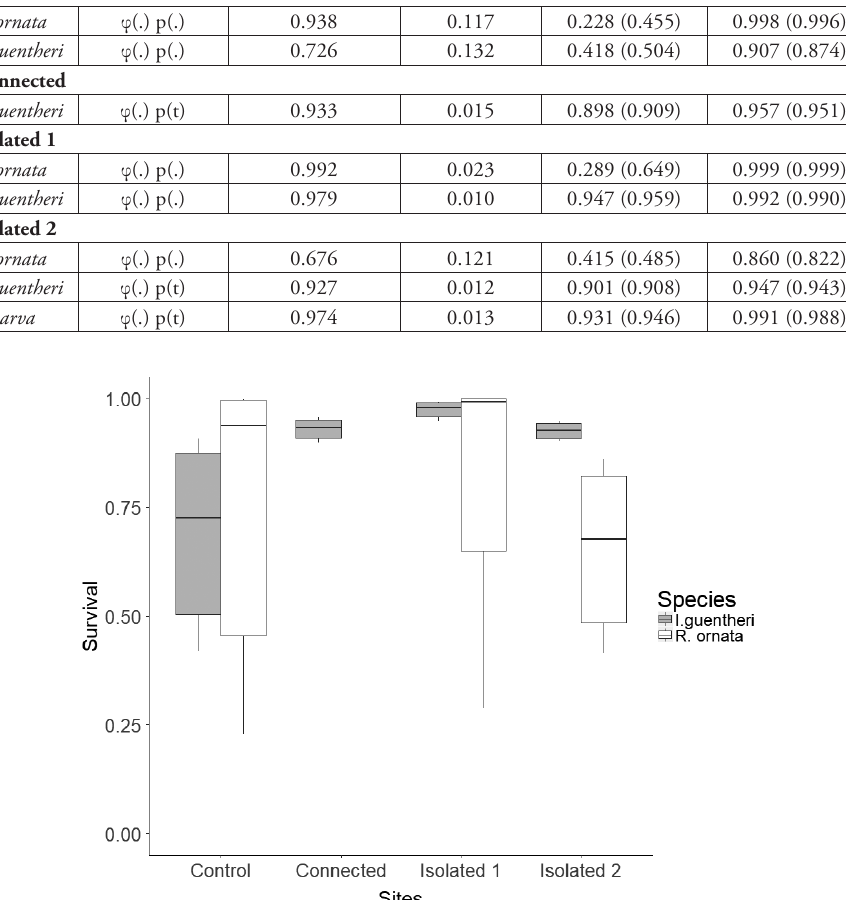
Table 3. Summary of the results of survival estimates in the different study sites. Species